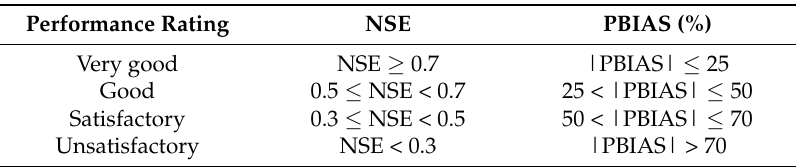
Table 3. Evaluation model criteria for daily time